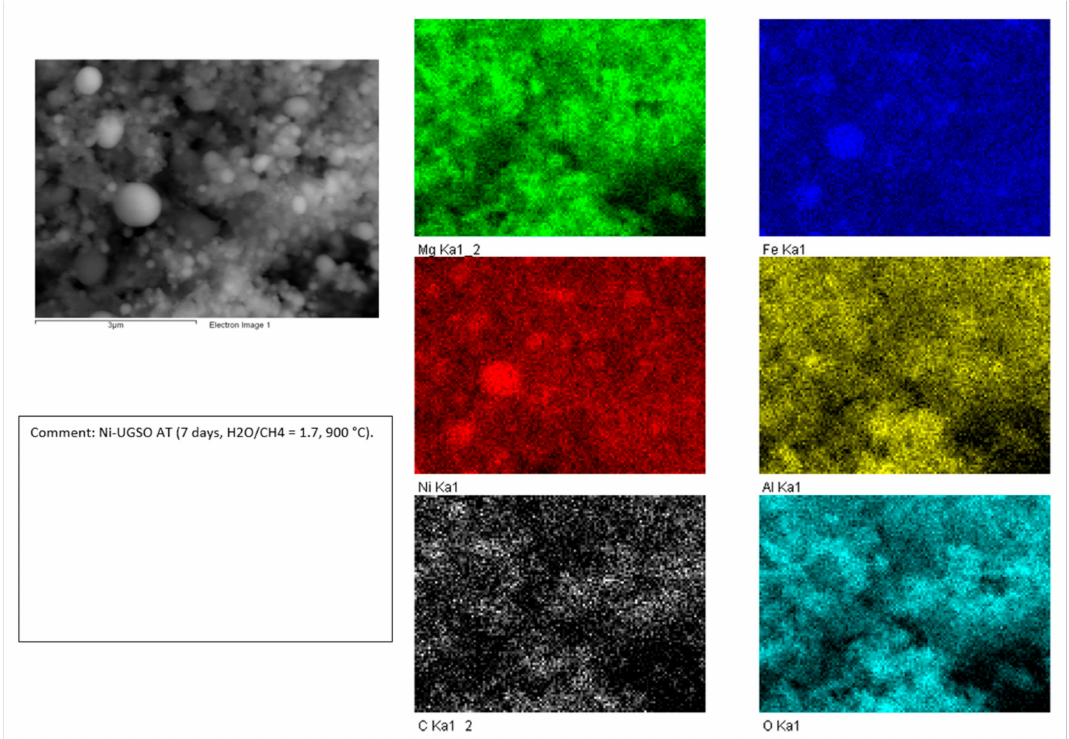
Figure 10. Mapping analysis of Ni-UGSO AT (7 days, H 2 O/CH 4 = 1.7, 900 ◦ C).